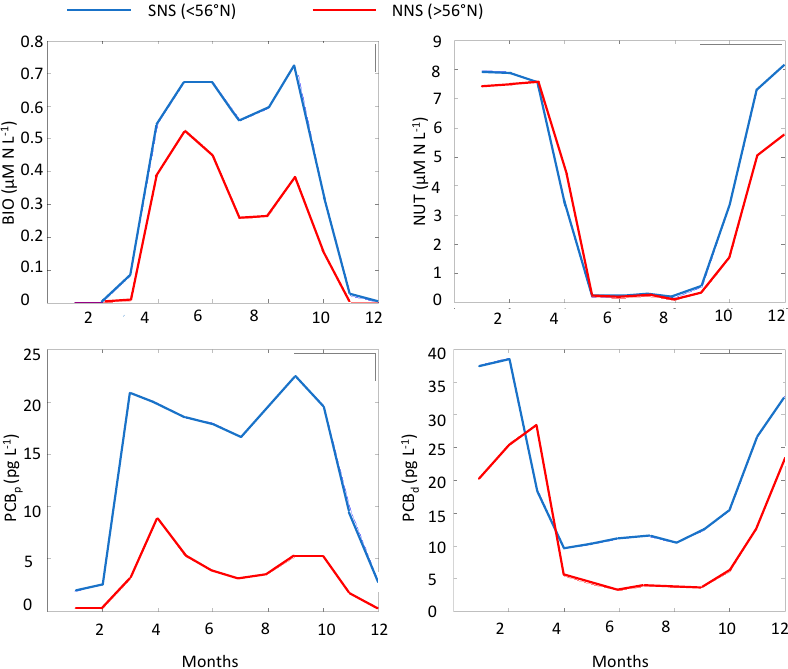
Figure 8. Estimated mean seasonal cycle of surface BIO, NUT, dissolved PCB (PCB d ), and particulate PCB (PCB p ). Average monthly mean values are given for the northern North Sea (NNS > 56° N) and for the southern North Sea (SNS < 56° N).